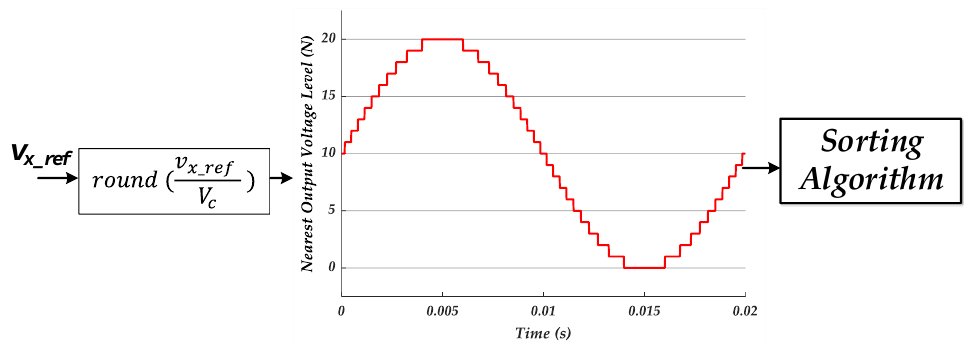
Figure 3. NLC and sorting blocks.